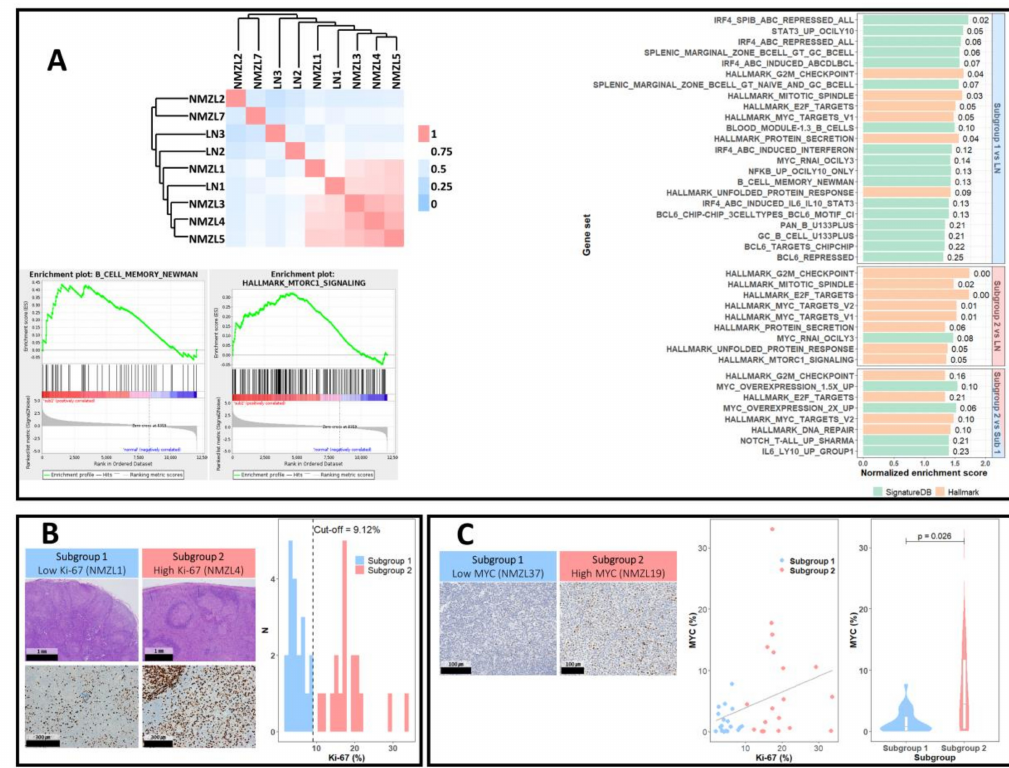
Figure 5. Subgroups of NMZL. ( A ) Pearson correlation matrix was created based on the GEPs of six NMZLs and three non-neoplastic LNs. An unsupervised clustering analysis revealed strong associations among NMZL3, 4, and 5, leading to determination of subgroup 1 (NMZL1, 2 and 7) and subgroup 2 (NMZL3, 4 and 5). GSEA between subgroup 1 and LNs and between subgroup 2 and LNs showed that certain gene sets were enriched in only one of the two subgroups. GSEA between subgroups 2 and 1 further supported the enrichment of cellular proliferation pathways and the MYC pathway in subgroup 2. ( B ) Ki-67 proliferation indices in the whole population was performed, and two subgroups were defined according to the median Ki-67 value. ( C ) Representative cases of MYC expression are shown. MYC positivity was assessed by digital image analysis and was 3.78% and 12.90% in NMZL37 (left) and NMZL19 (right), respectively. The scatter plot shows the association between Ki-67 proliferation index and MYC positivity, and the higher MYC positivity of subgroup 2 is shown as a violin